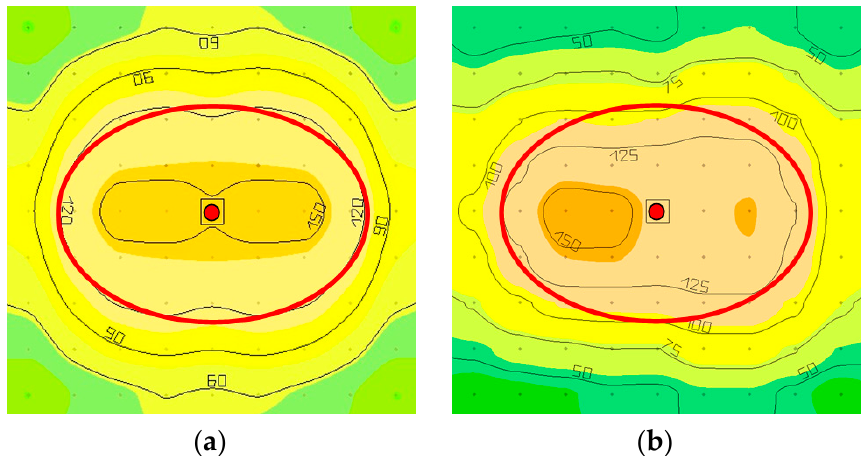
Figure 29. Option 3, illuminance distribution on the plane for asymmetrical distribution ( a ) results for a simulation model, ( b ) results for a luminaire prototype.